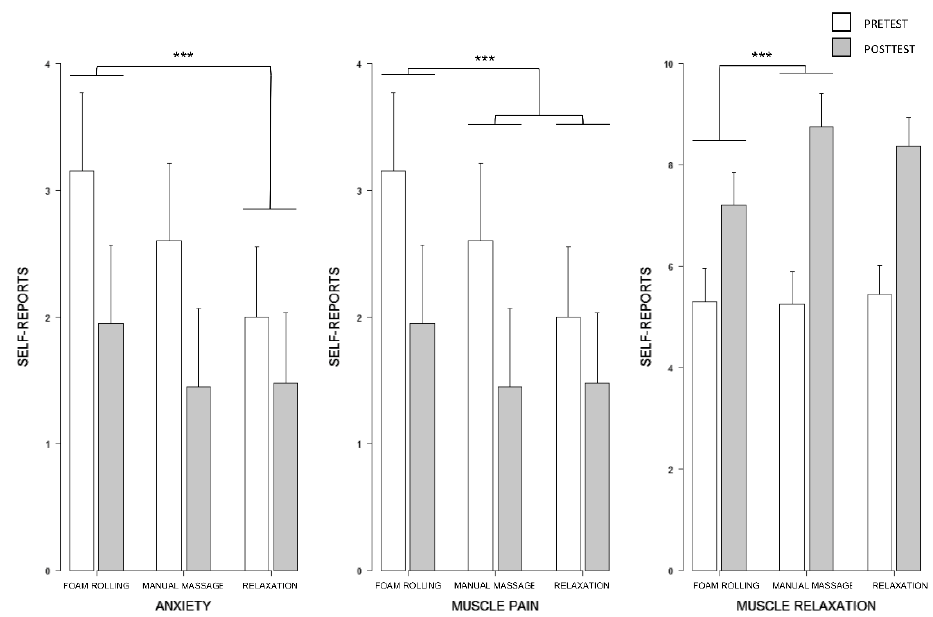
Figure 2. Barplot of the TEST × GROUP interaction effects obtained for subjective scores. Average fitted values by the linear mixed-effects analysis are presented with 95% confidence intervals (dotted bars). *** p < 0.001.